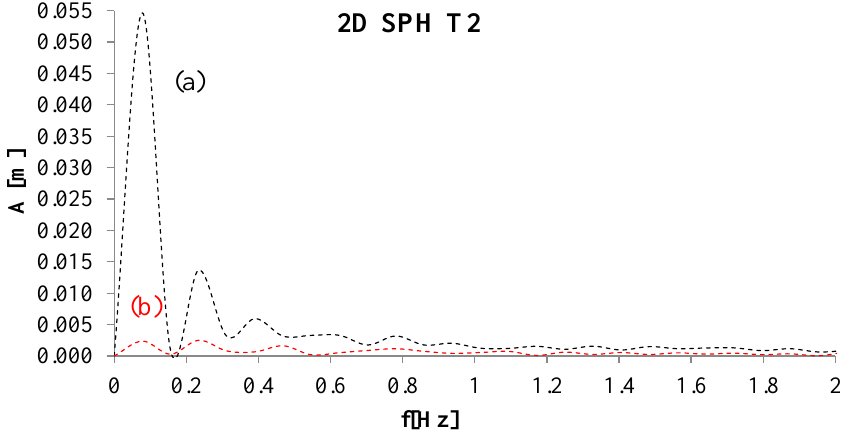
Figure 14. Test T2: Amplitude spectrum of the time series of the surface elevations: ( a ) upstream; and ( b ) downstream of the jump.